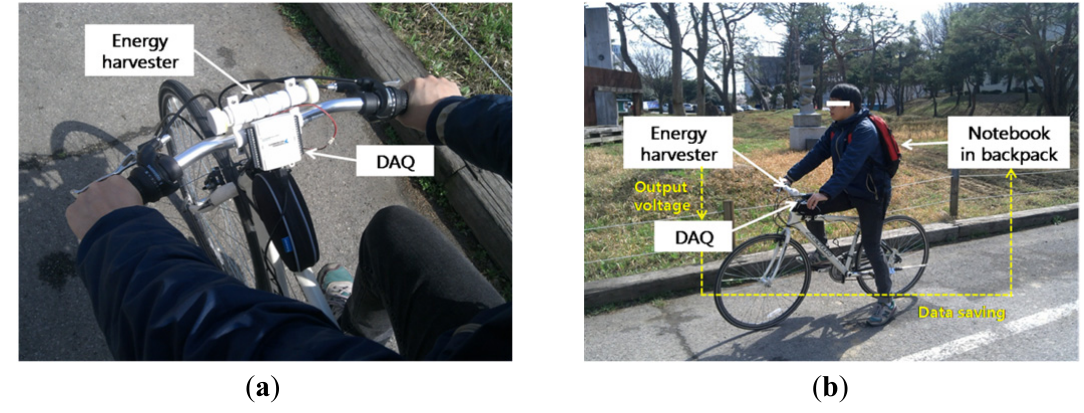
Figure 6. Experimental ride for the measurement of generated electricity.